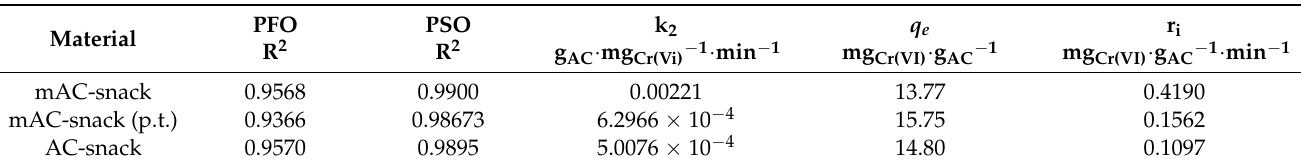
Table 3. Pseudo First and Pseudo Second Order kinetics comparison. Adsorption rate constant, Cr(VI) uptake at equilibrium stage, and initial adsorption rate calculation.